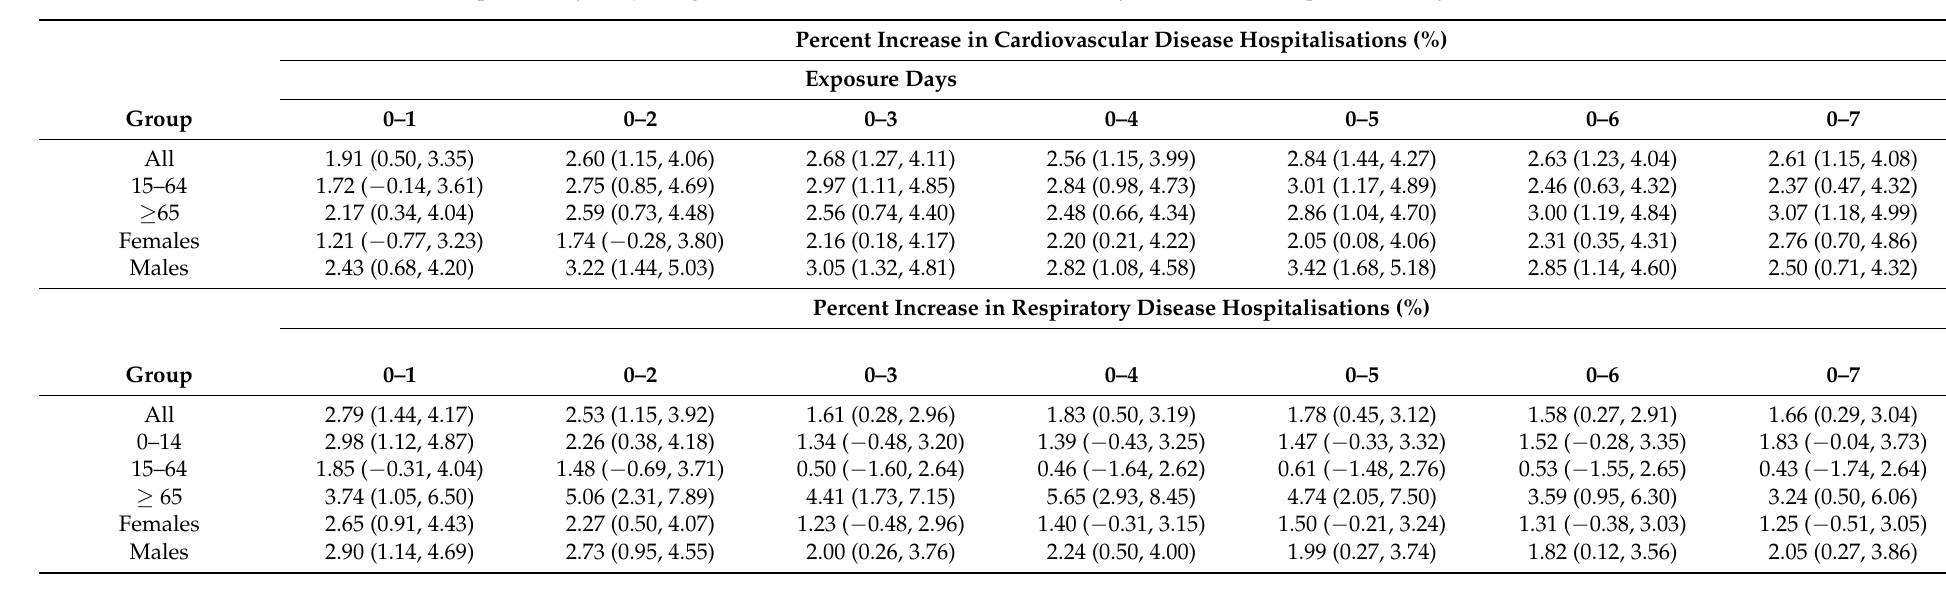
Table 4. Percent change (mean and 95% CI) of CVD and RD hospitalisations associated with an interquartile range (IQR) increase in temperature variability ( ◦ C) on different exposure days, adjusting for time trends and seasonal variation, day of the week, and public